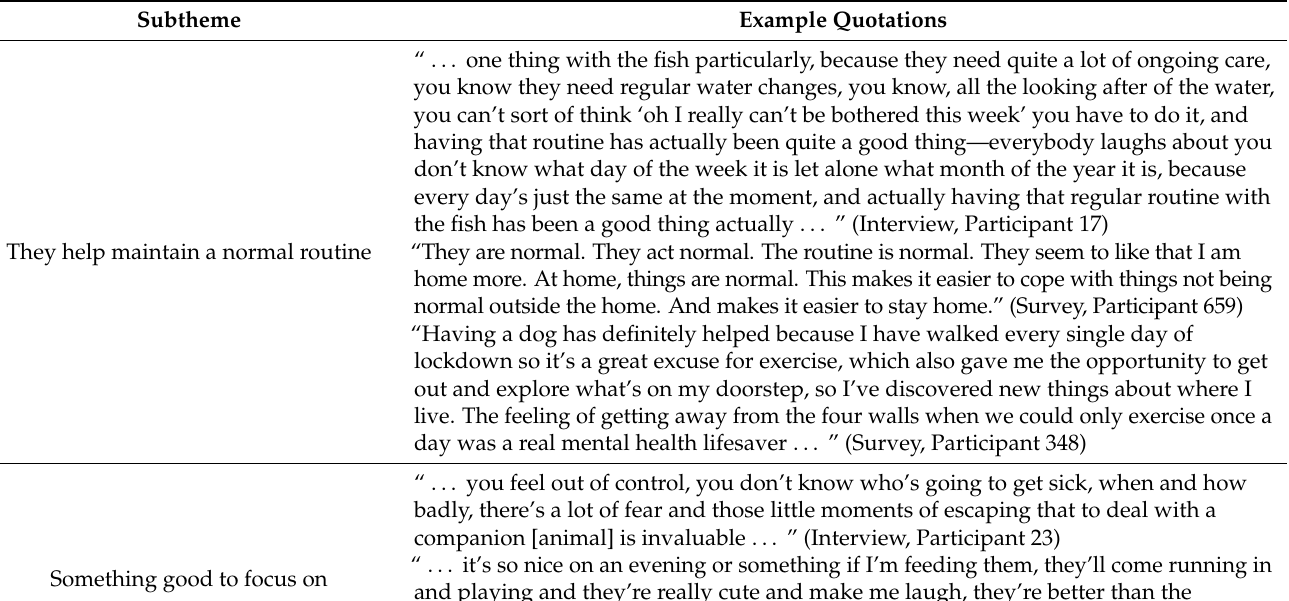
Table 4. Example quotations for “Companion animals as providers of purpose and